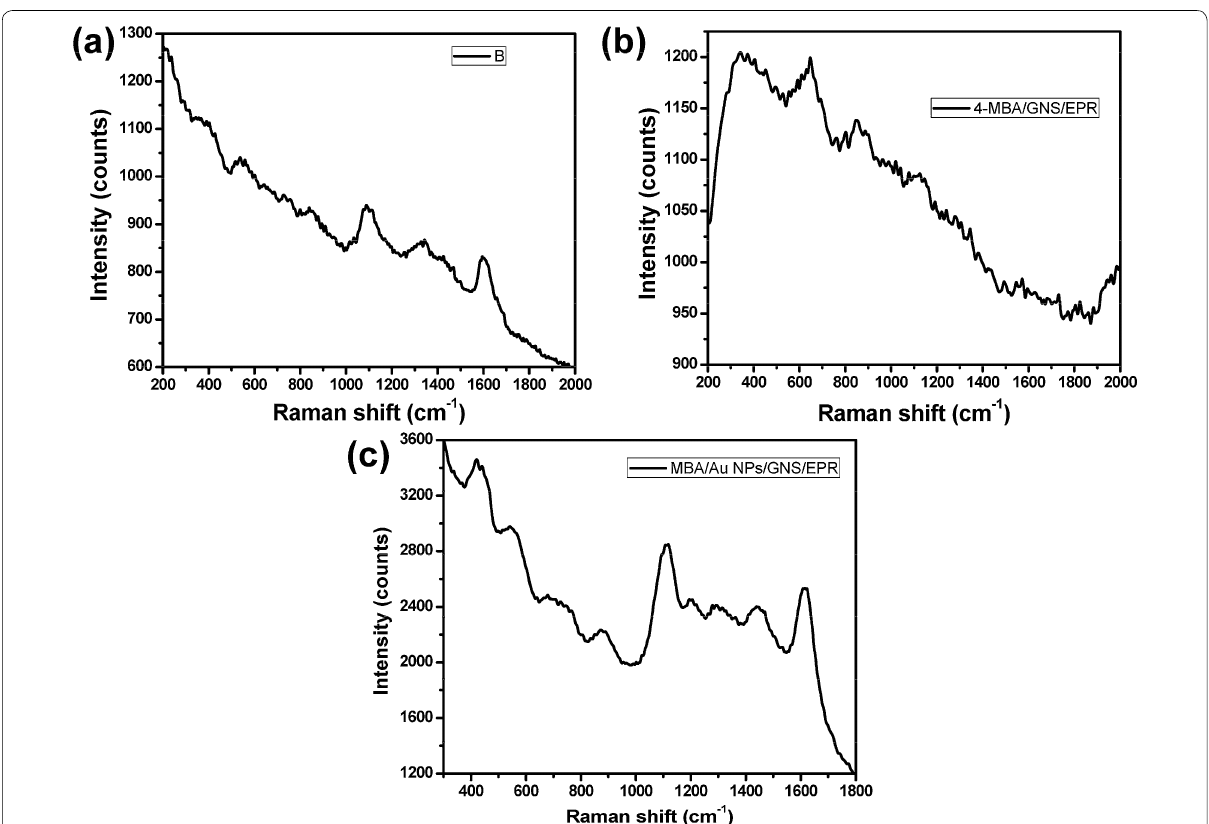
Fig. 7 Raman spectra of 2 mM of 4‑MBA with neat EPR ( a ), GNS/EPR 5 ( b ), and Au NPs/GNS/EPR 5 ( c